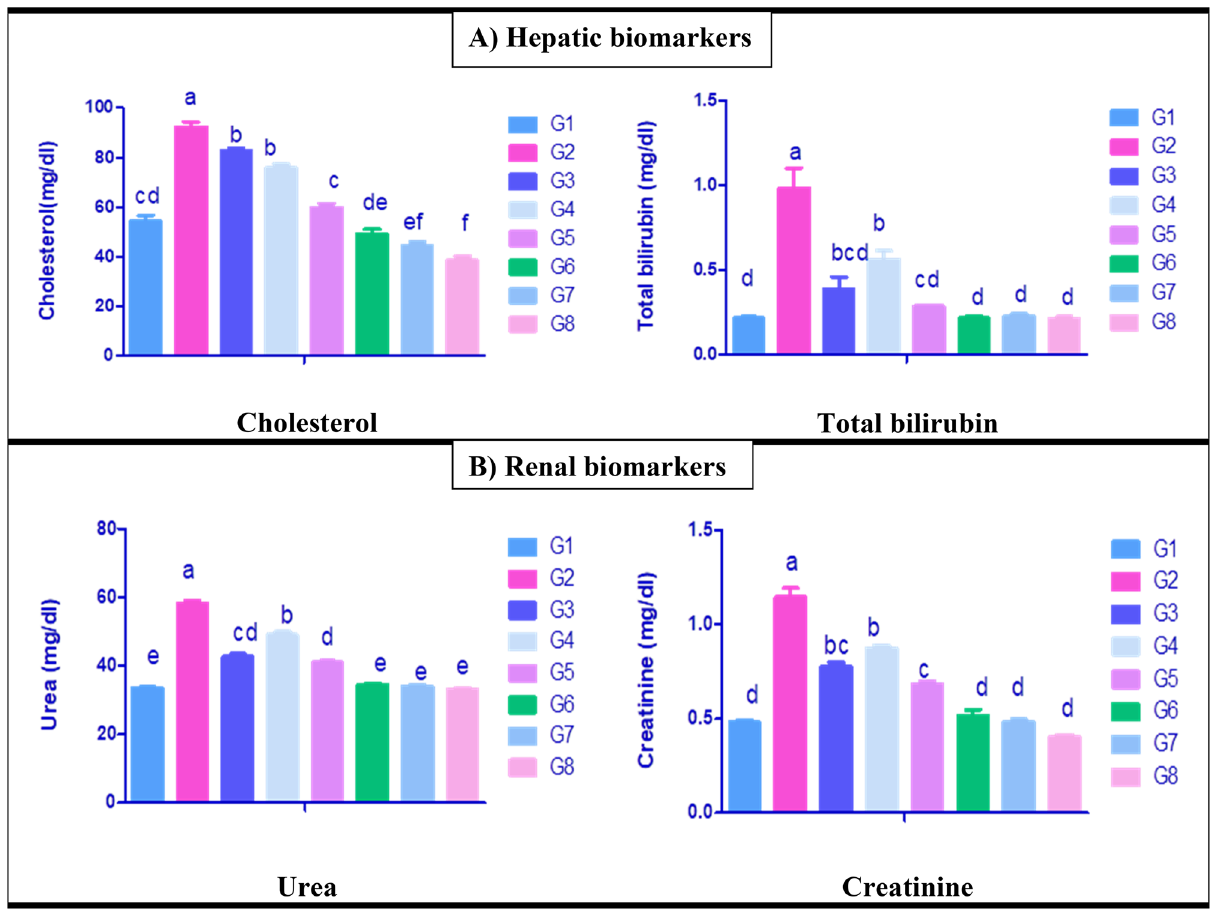
Figure 2. Serum biochemical parameters of hepatic and renal biomarkers of control and different treated rat groups. G1 = Control group, G2 = Paracetamol, G3 = Silymarin + Paracetamol, G4 = Chlorella vulgaris + Paracetamol, G5 = Chlorella vulgaris + Thiamine + Paracetamol, G6 = Silymarin, G7 = Chlorella vulgaris , G8 = Chlorella vulgaris + Thiamine. Data are presented as means ± SEM (n = 6). Different letter means significant difference effects in the same time